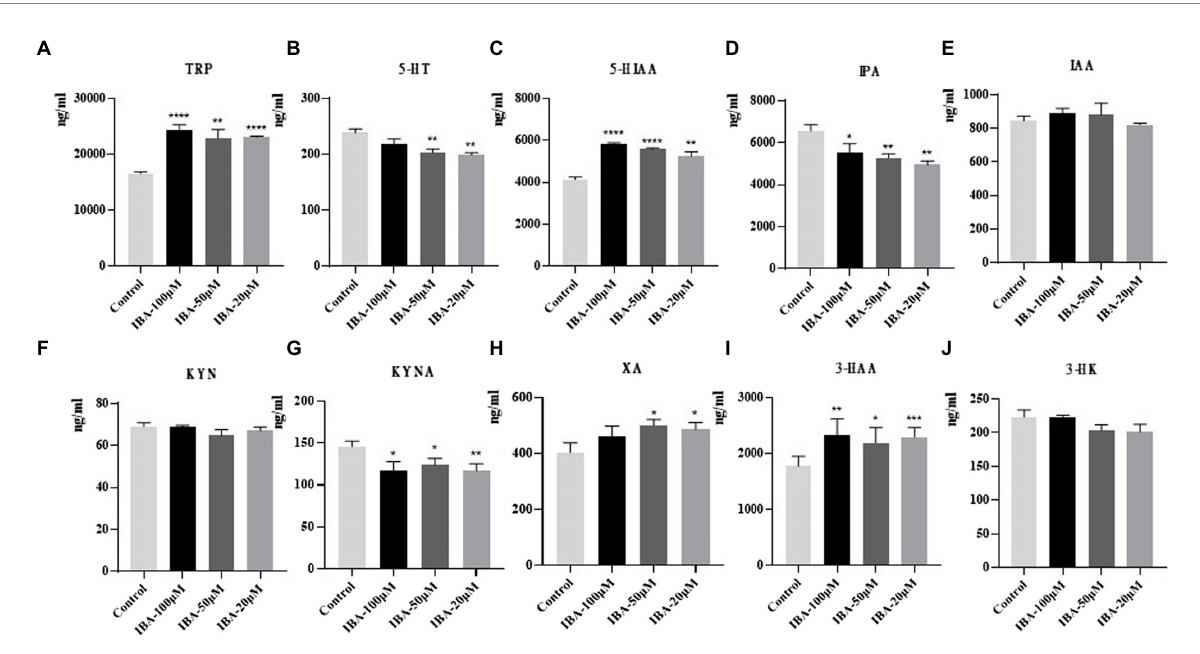
FIGURE 7 Results of drug intervention. Effects of IBA on (A) TRP, (B) 5-HT, (C) 5-HIAA, (D) IPA, (E) IAA, (F) KYN, (G) KYNA, (H) XA, (I) 3-HAA, and (J ) 3-HK in C. sporogenes . IBA, indole-3-butyric acid. Three concentration gradients were set for IBA: 100, 50, and 20 μ M (* p < 0.05, ** p < 0.01, *** p < 0.001, **** p < 0.0001 vs. control group).